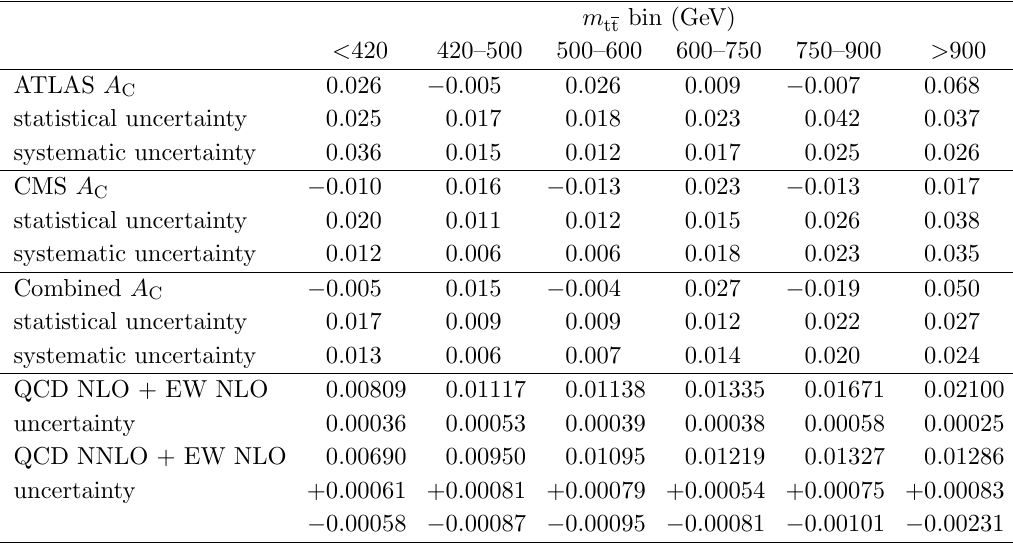
Table 4 . ATLAS and CMS charge asymmetry results at 8 TeV in six bins of m values along with statistical and systematic uncertainties. In addition the predictions from QCD calculations at NLO [19] and NNLO [23] are given.